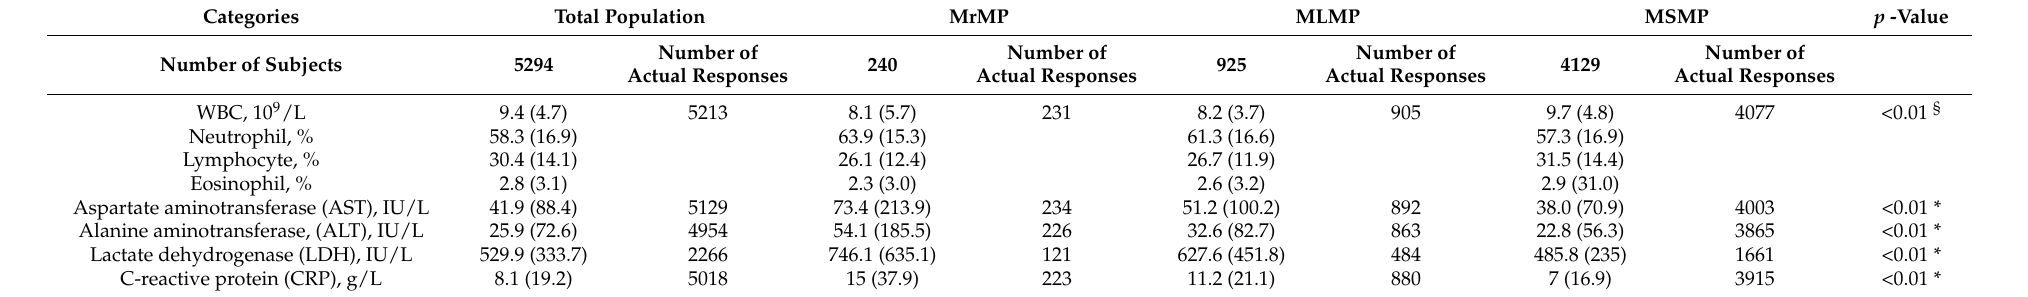
Table 3. Comparison of serum markers at admission among the clinical response